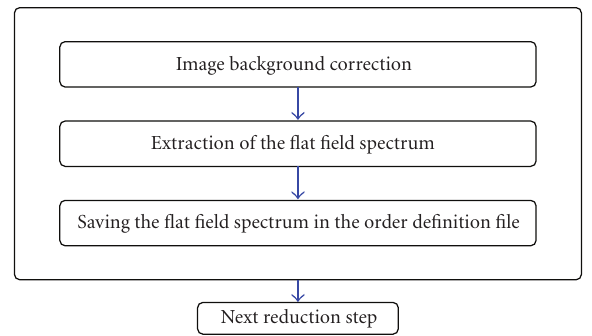
Figure 4: Flow chart with the main steps of the blaze